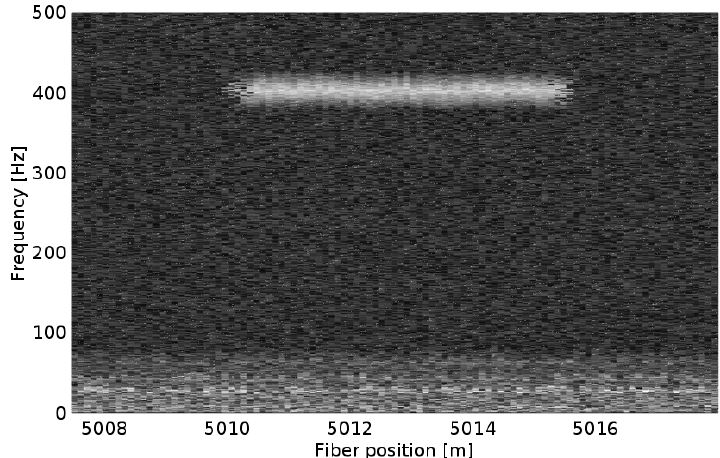
Figure 10. Harmonic tone response of the system with the setup shown in Figure 9. The fiber sample rate was 10 kHz, and the data were averaged with an averaging factor of 10. The final sample rate for the track was 1 kHz. The 400 Hz tone is visible along a fiber length below 6 m.